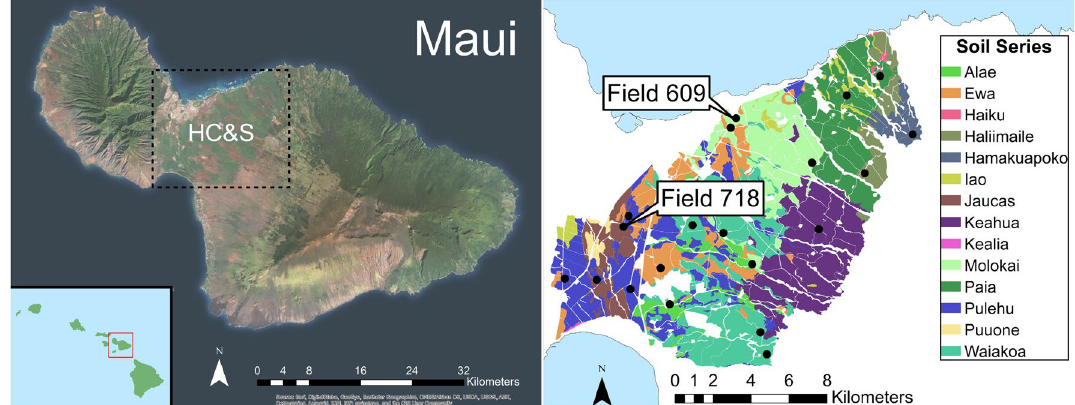
Figure 1. Hawaiian Commercial and Sugar in central Maui with main Hawaiian Islands inset (left). Soil series identified by NRCS across HC&S fields (right) with black dots indicating 20 locations where soils were sampled to test landscape level differences in topical soil kinetics and associated soil properties under conventional sugarcane. Maps from Ref. 19 created using ESRI ArcGIS with soil series data from: Soil Survey Staff, Natural Resources Conservation Service, United States Department of Agriculture, Web Soil Survey, Available online at http:// webso ilsur vey. nrcs. usda. gov/. Accessed [07/30/2016] 19